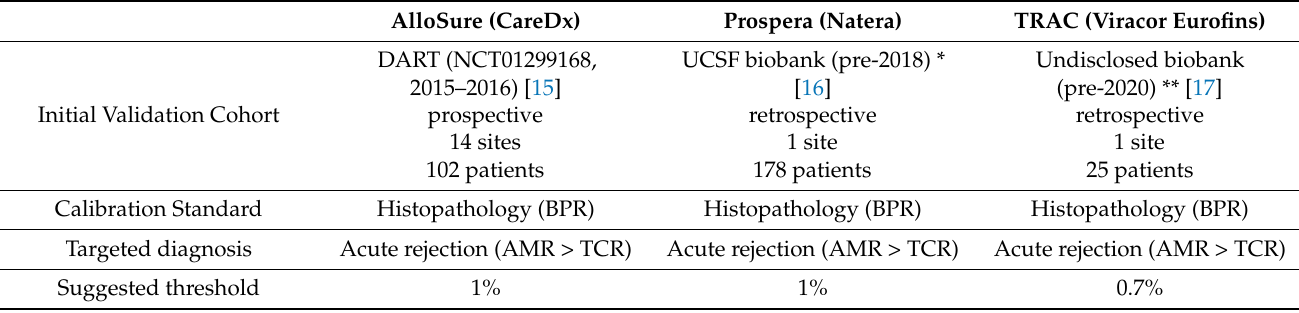
Table 1. Summary of characteristics of commercially available clinical ddcfDNA tests in the US for use in transplant recipients with suspicion of acute